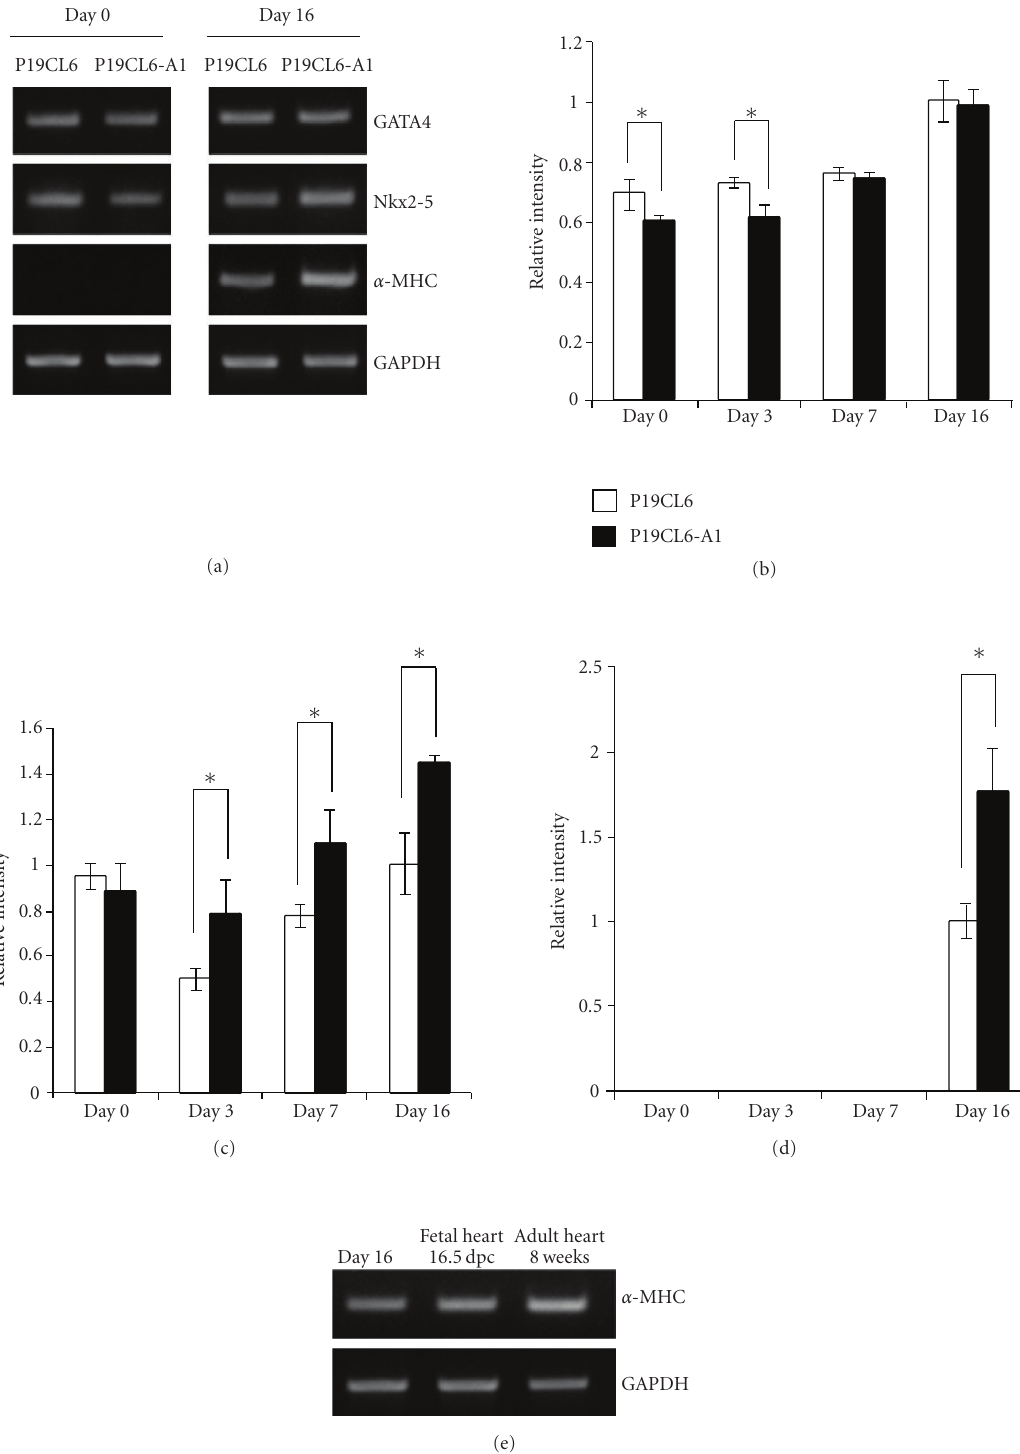
Figure 3: Amplification of GATA4, Nkx2-5, and α -MHC mRNAs by RT-PCR. (a) Expression of GATA4, Nkx2-5, and α -MHC in the P19CL6 cells di ff erentiated by the basal protocol and the P19CL6-A1 cells by the developed protocol on day 0 and 16, respectively. ((b), (c) and (d)) Densitometric quantification of the amplification levels of GATA4 (b), Nkx2-5 (c), and α -MHC (d) in the P19CL6 and P19CL6-A1 cells in the respective di ff erentiation protocols on day 0, 3, 7, and 16. Data from three independent experiments, normalized to the levels of the GAPDH amplification products, are shown as mean ± SE. Comparisons between the data of P19CL6 and P19CL6-A1 cells were performed using unpaired t -test. ∗ P < . 05 (e) Amplification of α -MHC mRNAs by RT-PCR in the P19CL6-A1 cells di ff erentiated by the developed protocol with DMEM on day 16, and the heart ventricles of 16.5 dpc fetal and 8-week-old